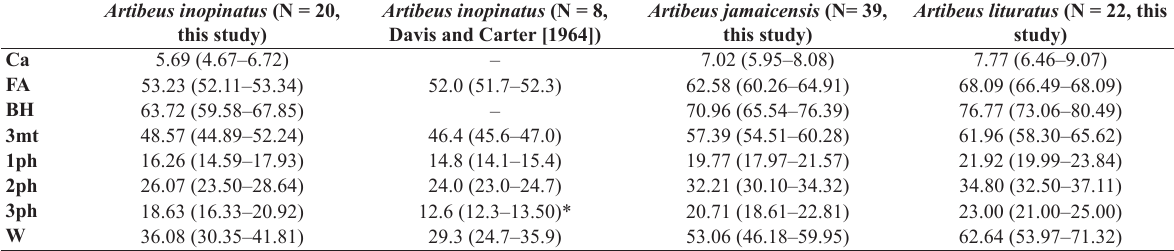
Table 3. ANOVA results of the eight studied characters of the three species of Artibeus . Note the comparison of the external mea- surements of Artibeus inopinatus of our records with those presented by Davis and Carter (1964). Artibeus inopinatus (N = 20, Artibeus inopinatus (N = 8, Artibeus jamaicensis (N= 39, Artibeus lituratus (N = 22, this this study) Davis and Carter [1964]) this study)